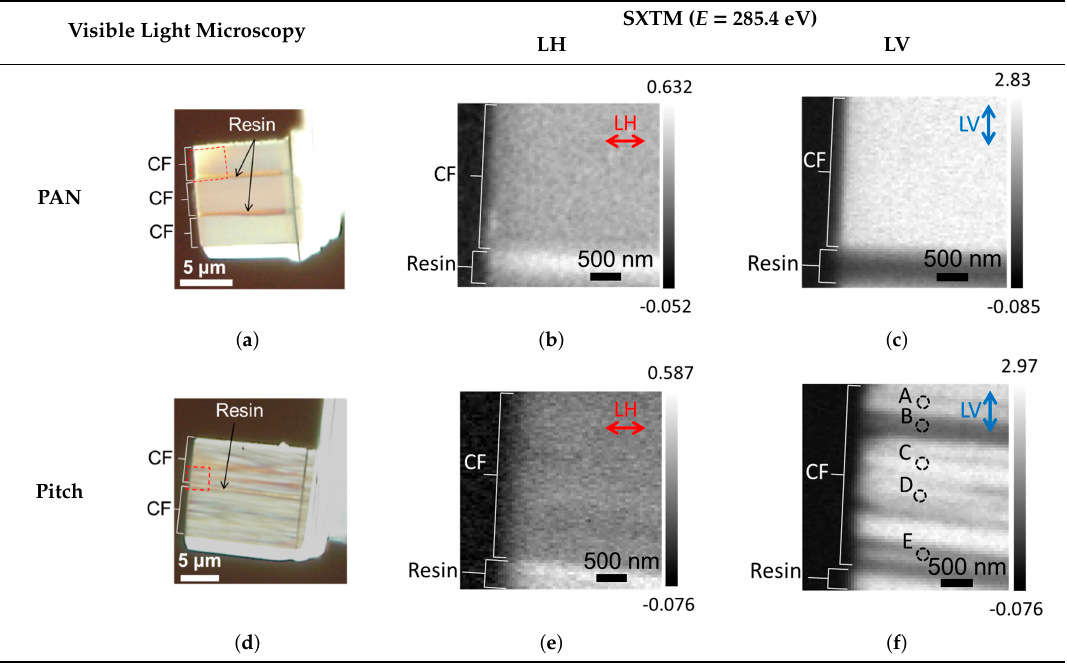
Table 3. ( a ), ( d ) Visible light microscopy images of the longitudinal sections of PAN- and pitch-based CFs, respectively, which contain the field of view of STXM (OD) images (red dotted line areas); ( b – c ), ( e – f ) the STXM images of PAN- and pitch-based CFs, respectively, are the OD contrast of the X-ray absorption with linear horizontal (LH) and linear vertical (LV) polarized beams.